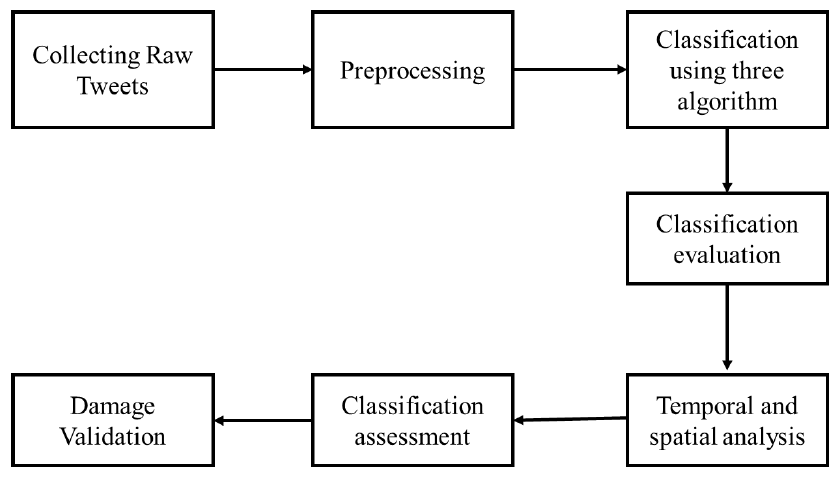
Figure 2. Flowchart of the study.